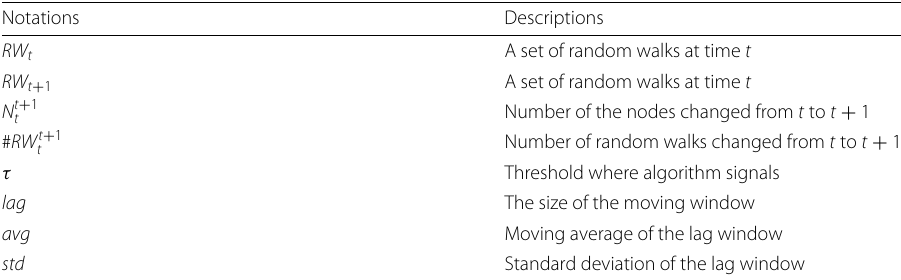
Table 2 Summary of notations used in decision-making algorithm